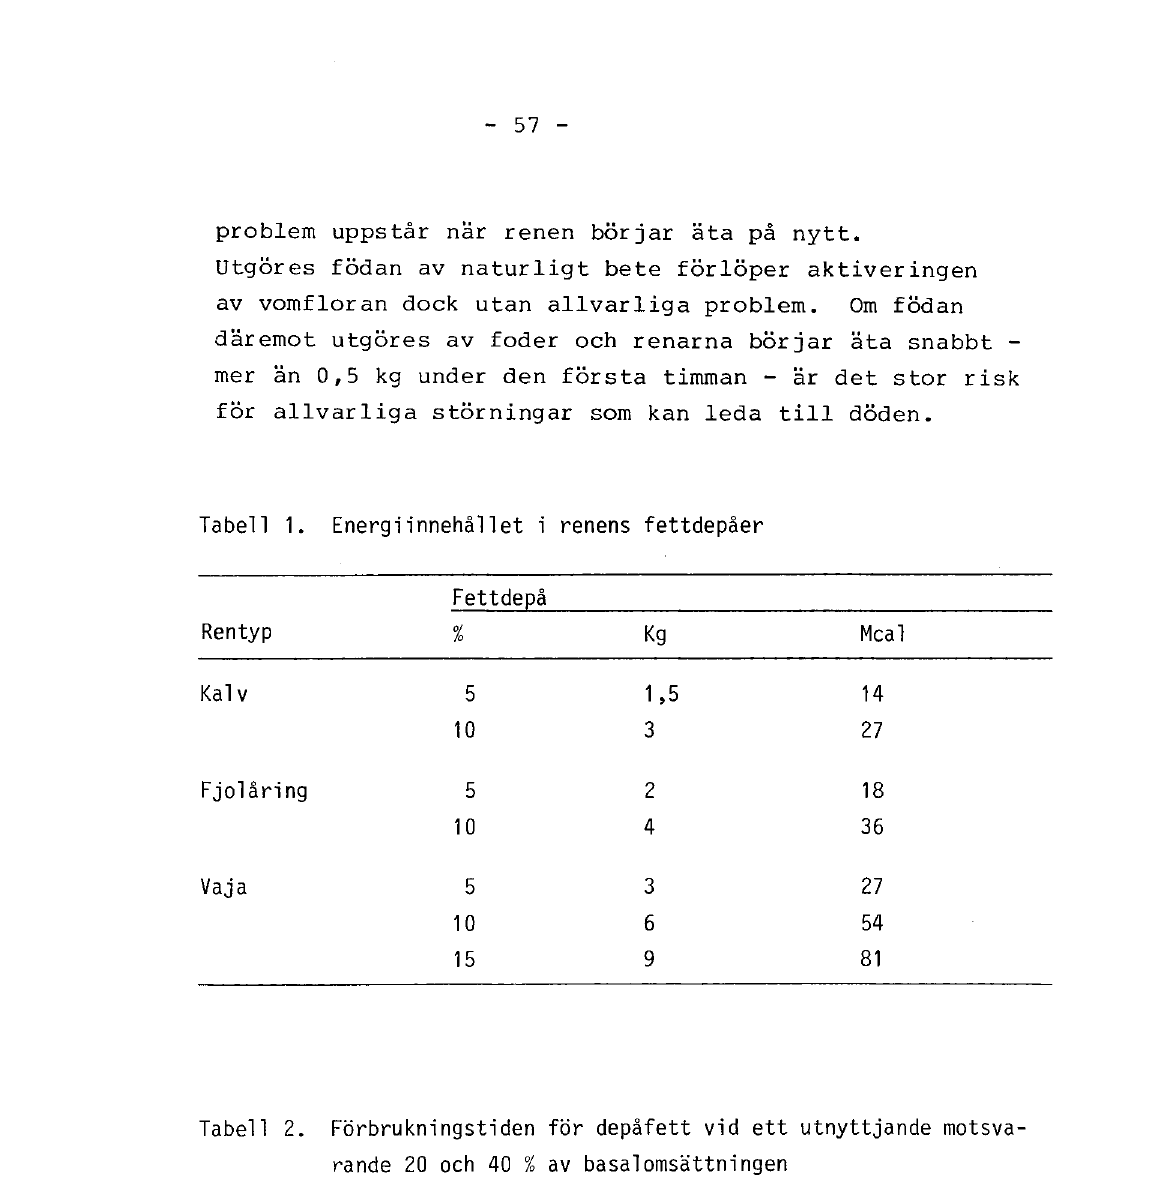
Tabell 1. Energiinnehållet i renens fettdepåer